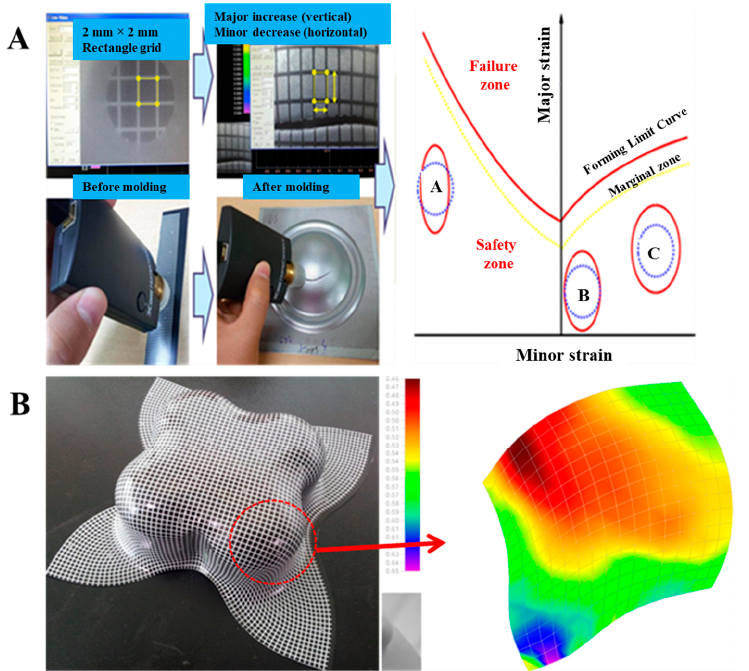
Figure 3. Failure and safety zone in FLD and ASAME strain analysis: ( A ) Failure and safety zone in FLD and ( B ) cross-die test sample ASAME target model strain analysis.